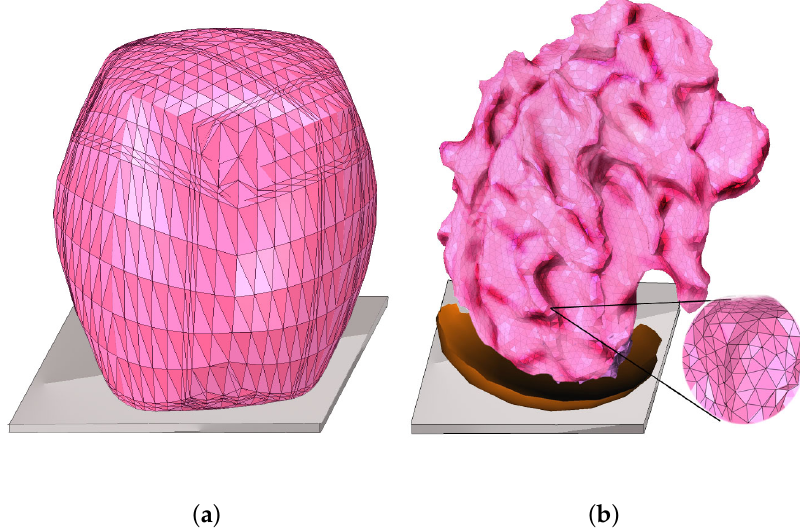
Figure 5. Simplified model of a head used for minimisation ( a ) and a full-scale, meshed model used for accurate acceleration mapping ( b